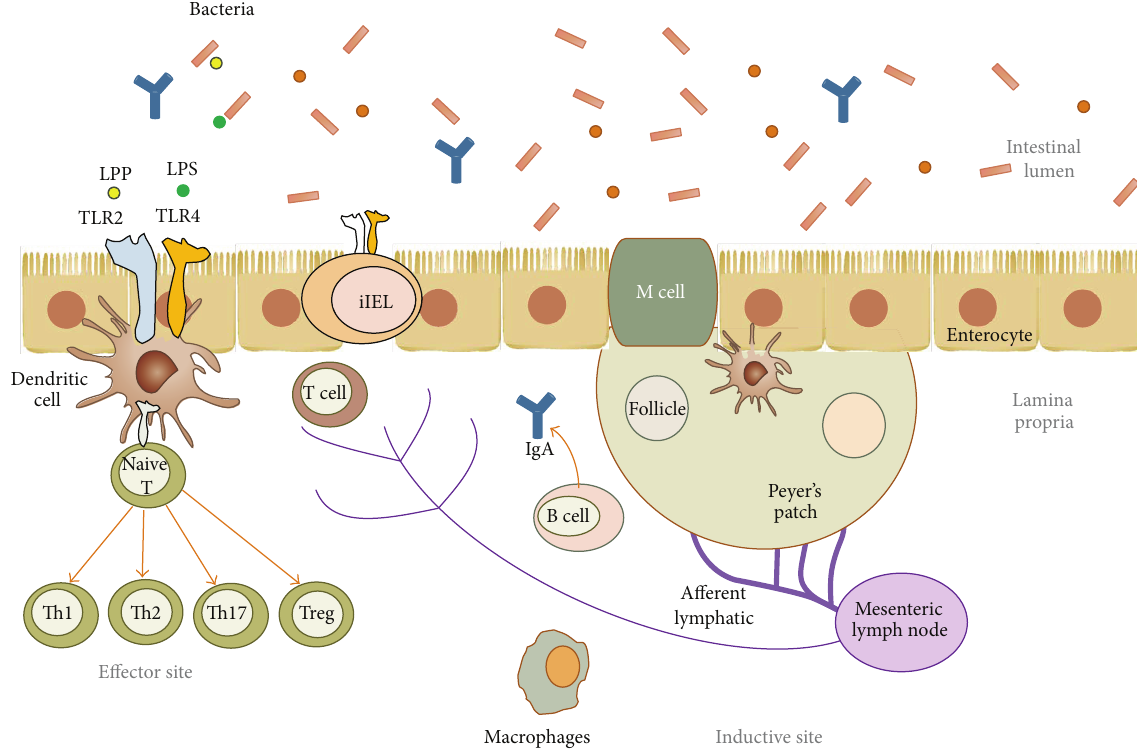
Figure 2: Induction of an immune response through gut-associated lymphoid tissue